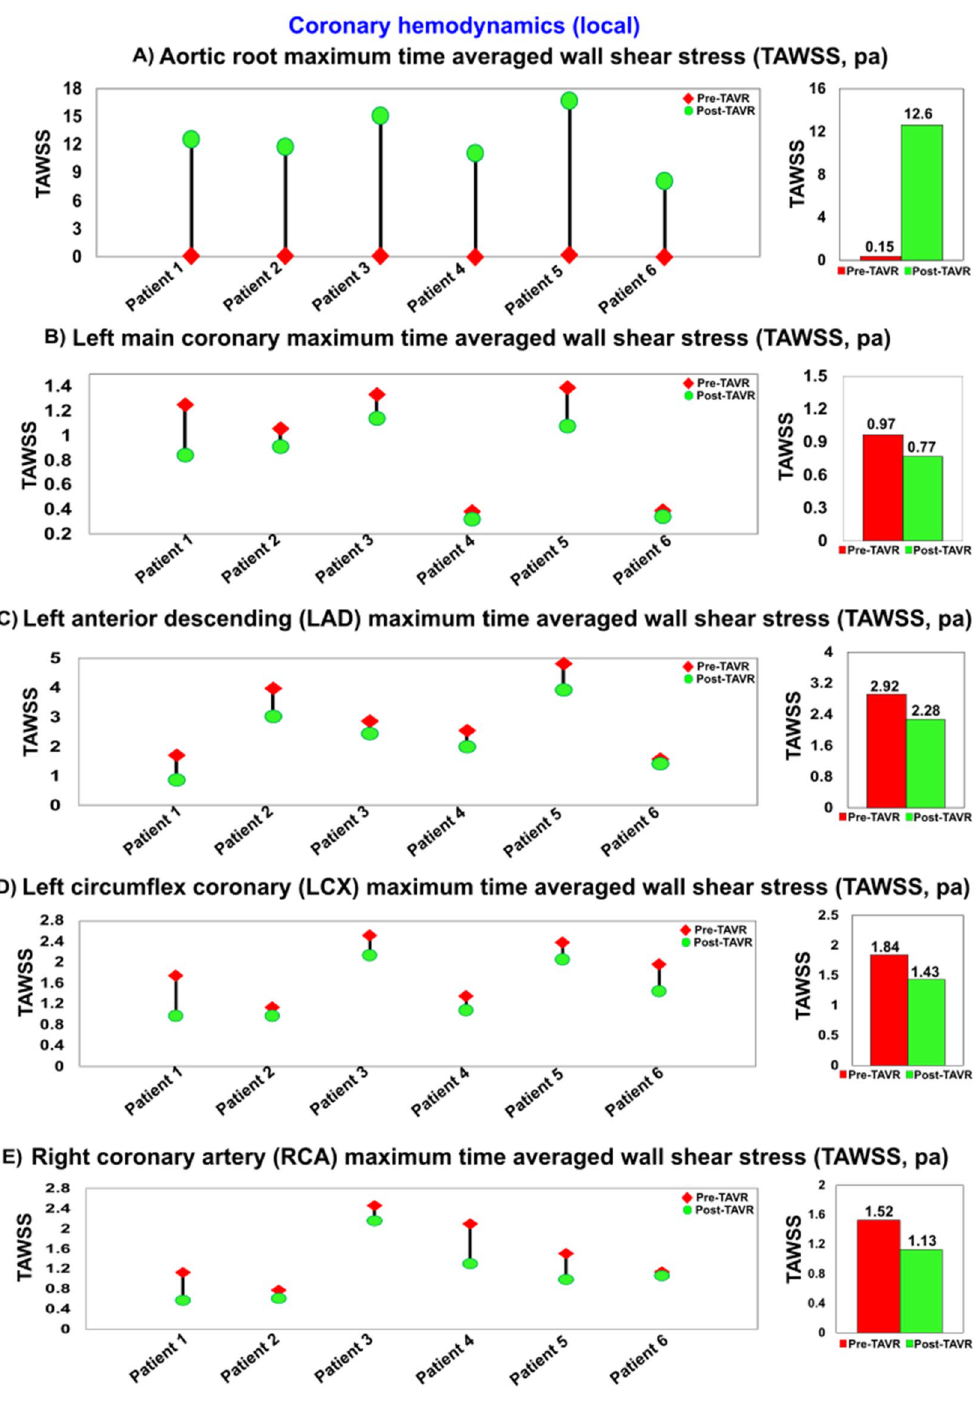
Figure 15. Changes in local hemodynamics in patients between baseline and 90-day post-TAVR (N = 6). ( a ) Aortic root maximum TAWSS; ( b ) Left main coronary maximum TAWSS; ( c ) Left anterior descending coronary artery maximum TAWSS; ( d ) Left circumflex coronary artery maximum TAWSS; ( e ) Right coronary artery maximum